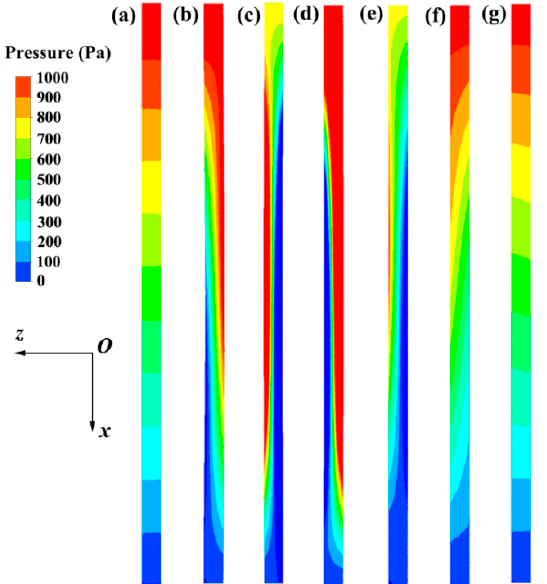
Figure 10. Contours of the pressure distribution of liquid hydrogen on the plane of y = 0 ( a – g corresponding to the time of 0, 0.01 s, 0.02 s, 0.03 s, 0.04 s, 0.2 s and 0.3 s, respectively).